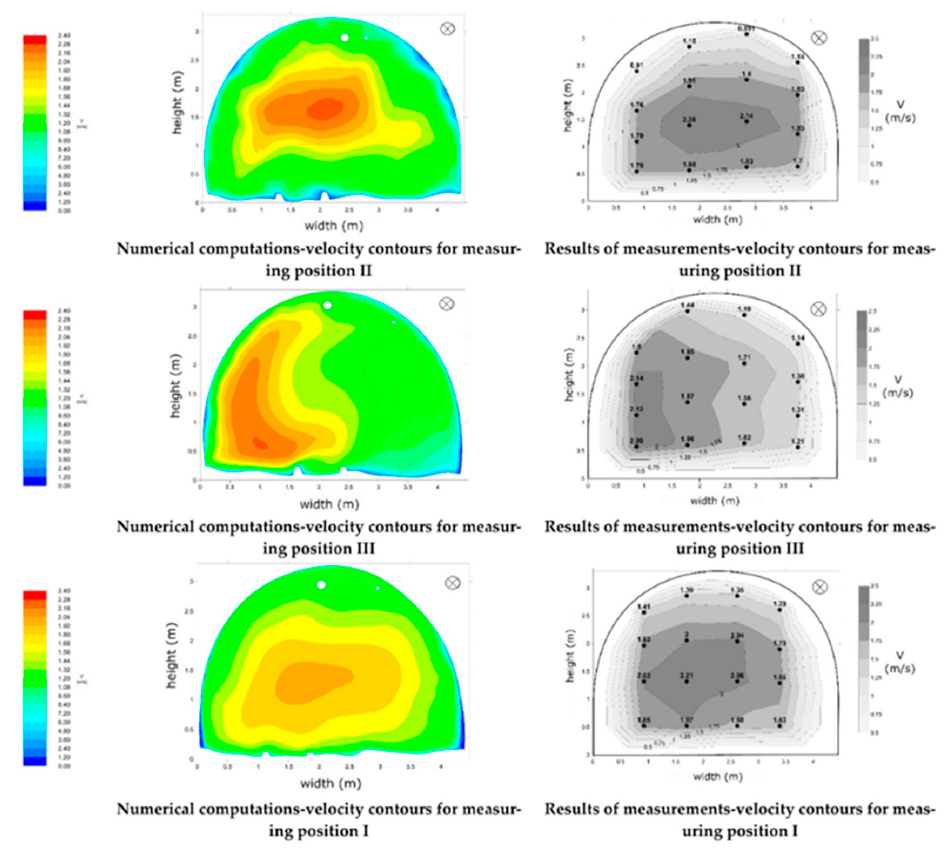
Figure 8. Comparison of the numerical and measurement results (m/s) for three measuring positions [48].